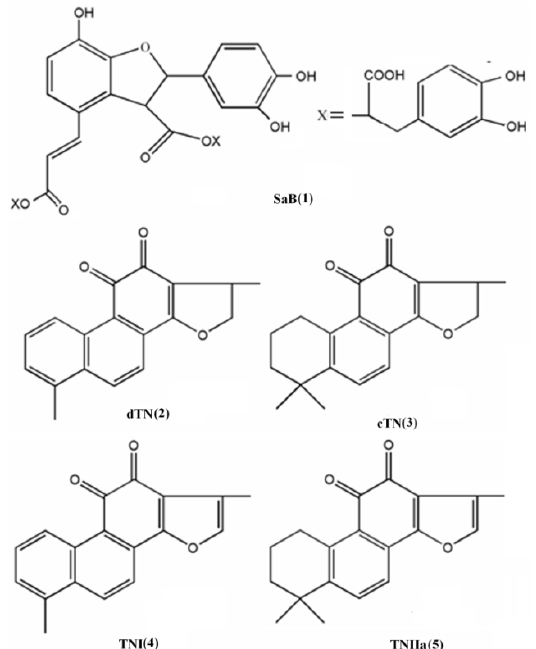
Figure 1. Structures of the five major compounds of Danshen: (1) salvianolic acid B